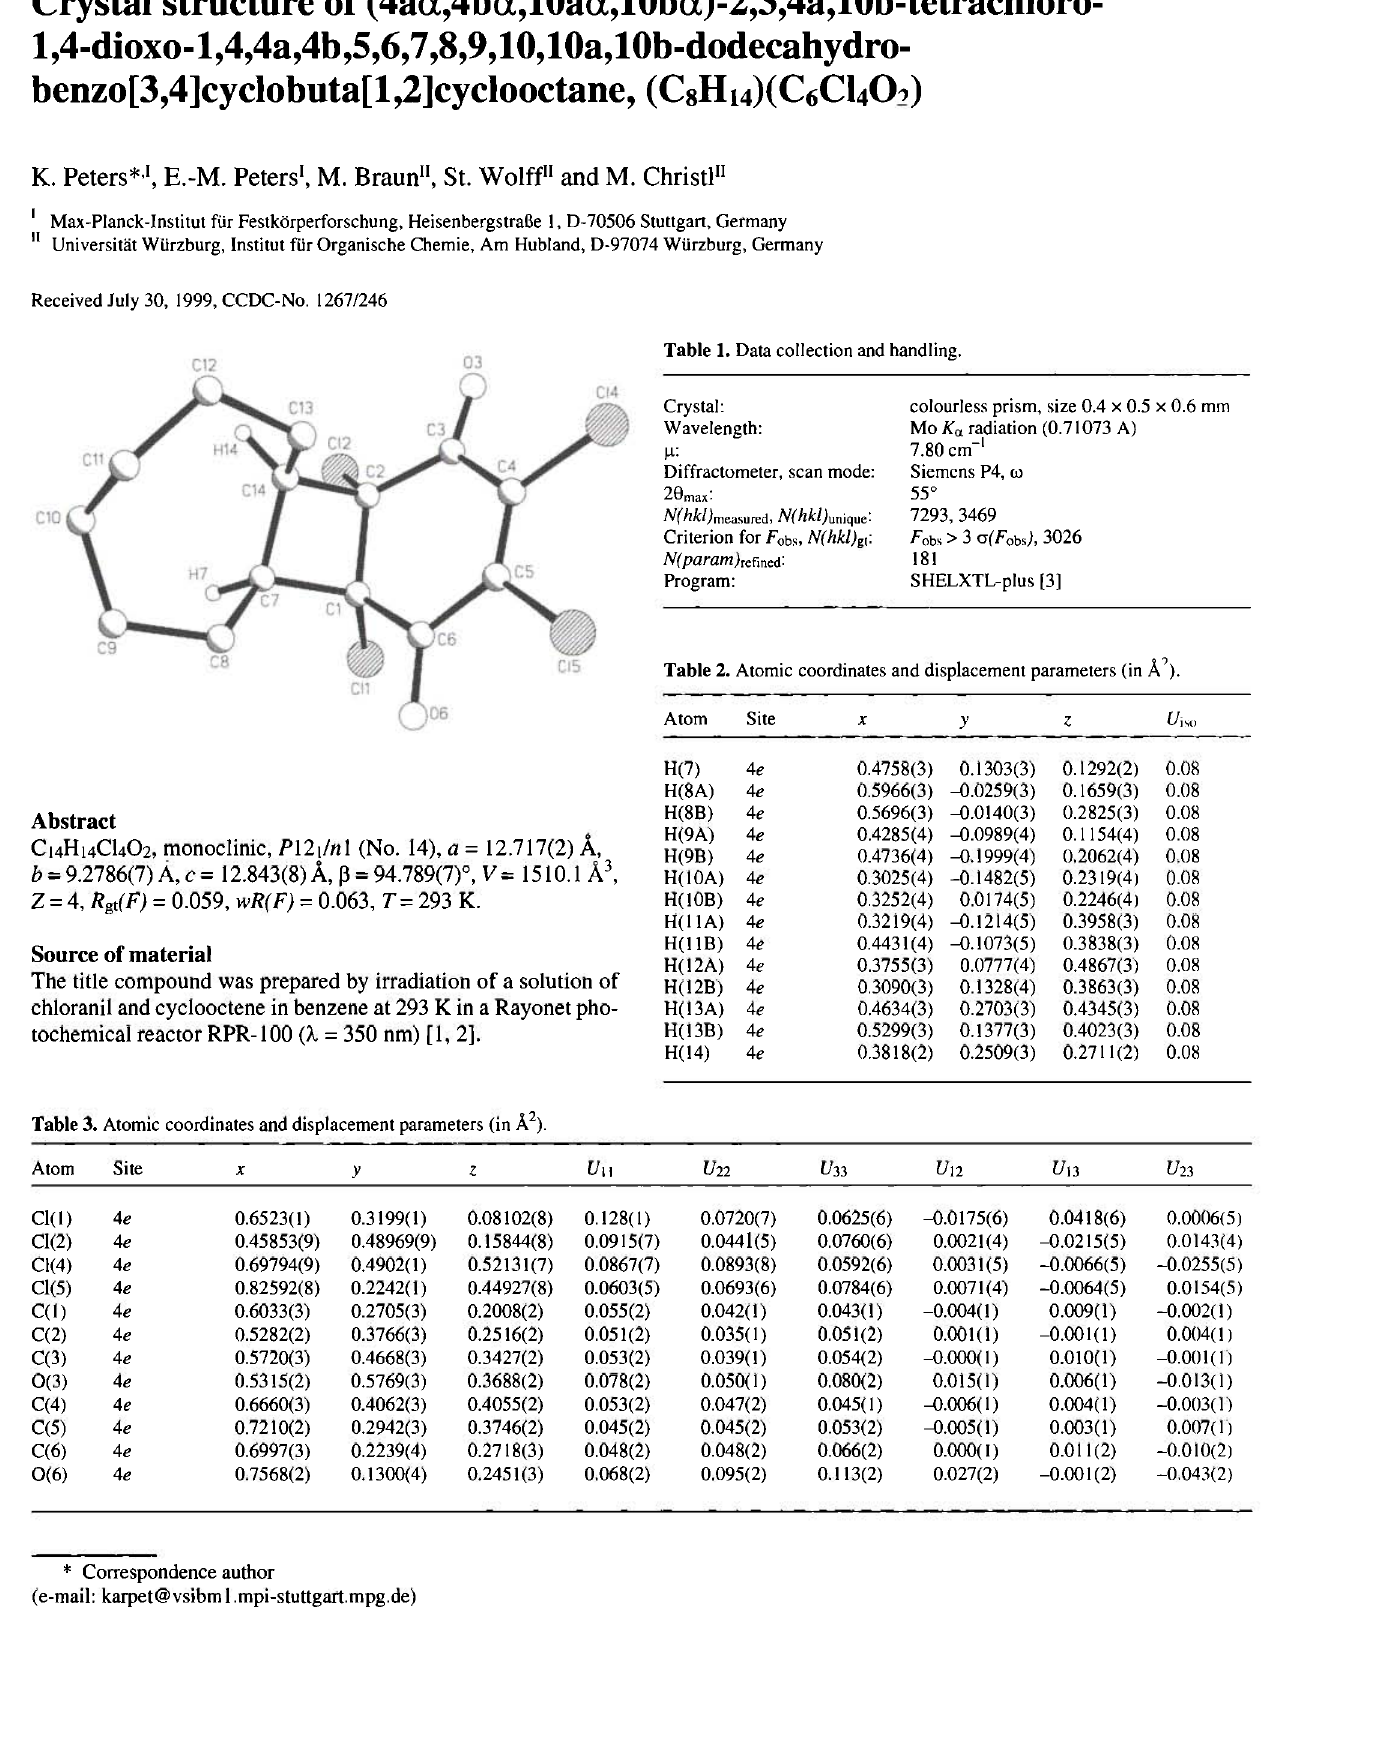
Table 2. Atomic coordinates and displacement parameters (in A').